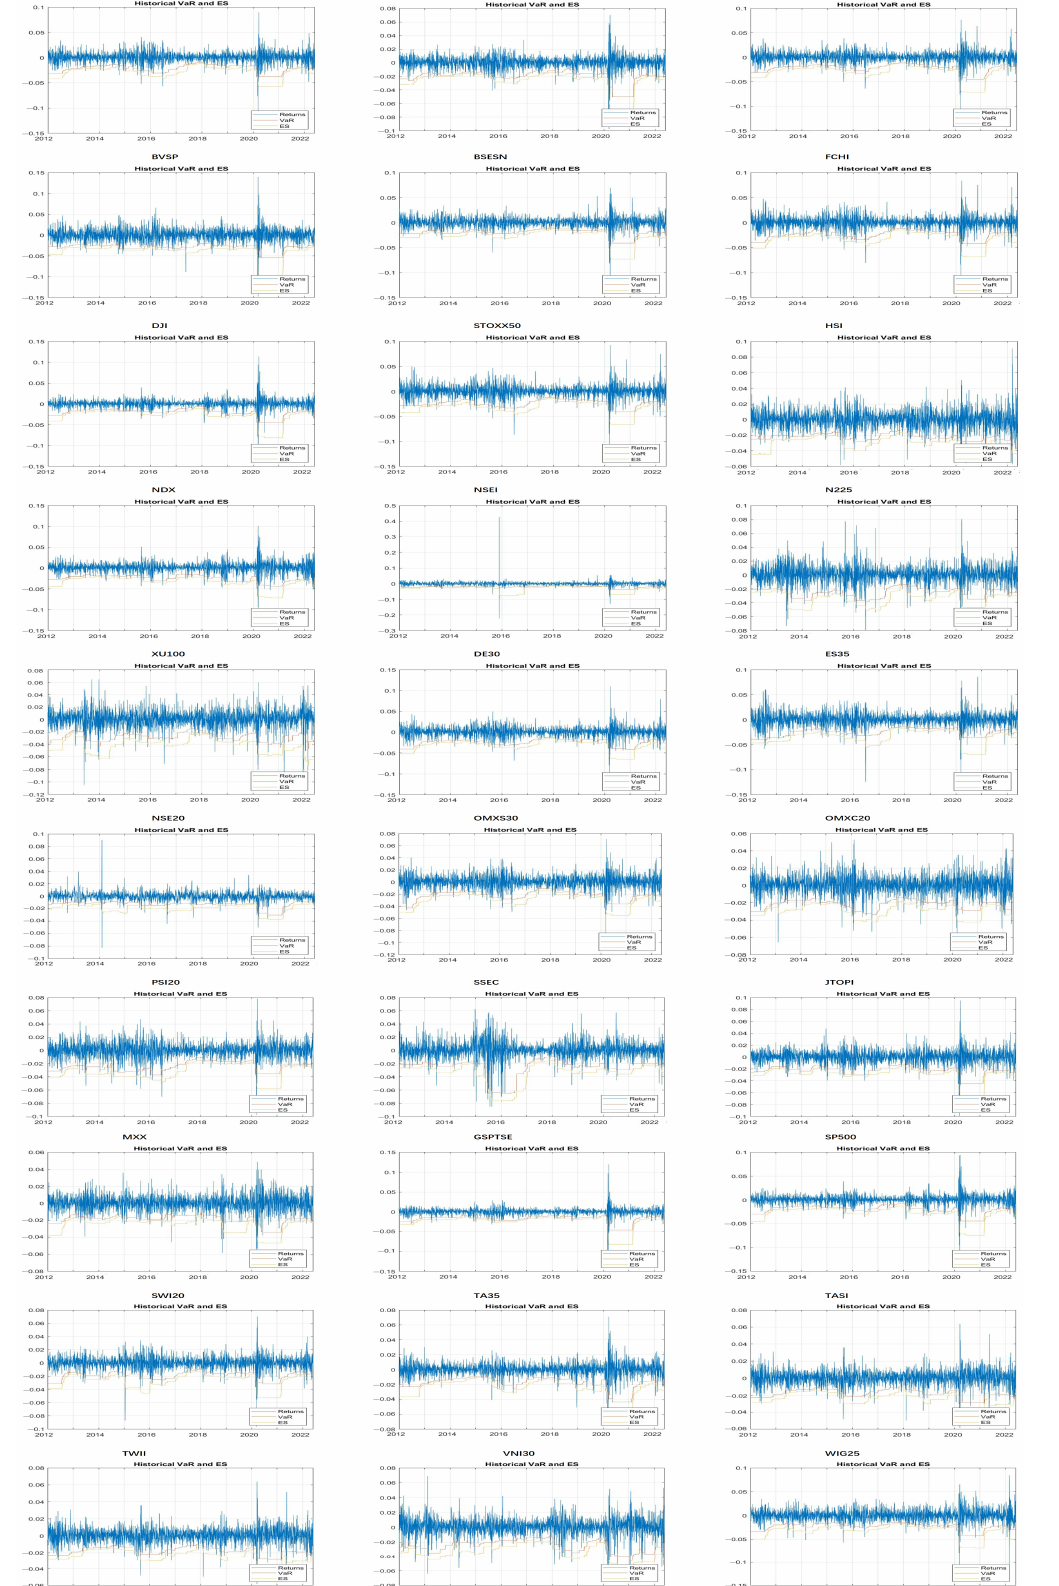
Figure 3. Lognormal Return, VaR and ES of 30 Stock Indices, 1 January 2012–1 June 2022